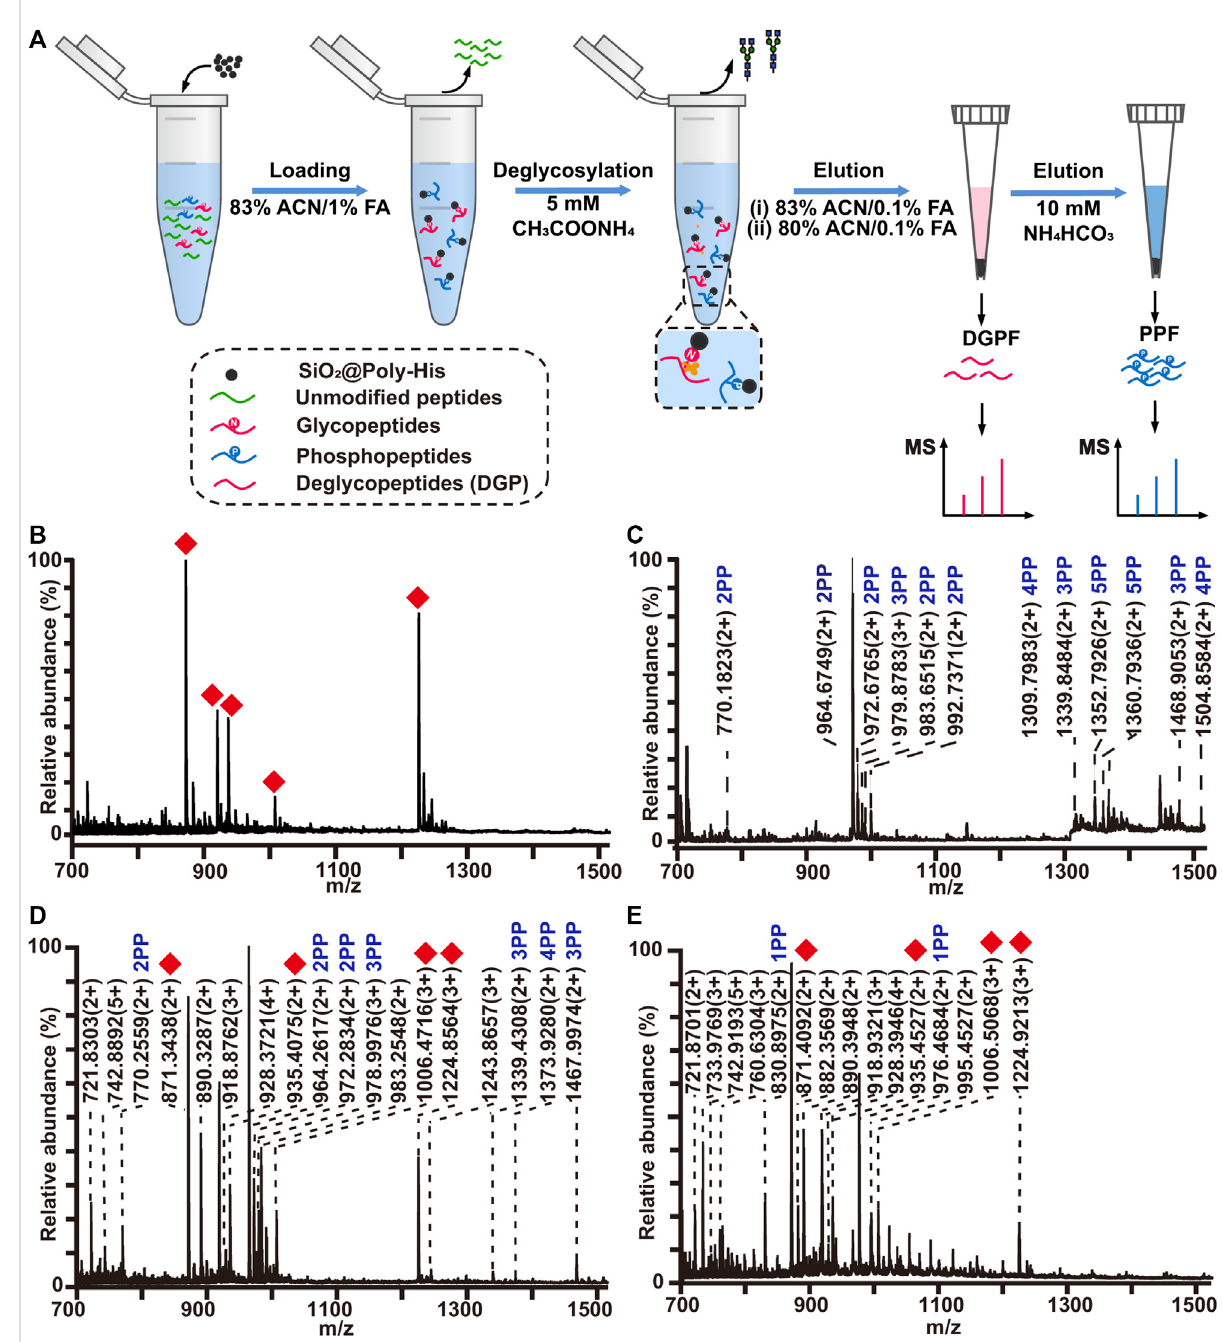
FIGURE 5 (A) Work fl ow the simultaneous enrichment with SiO 2 @Poly-His microspheres, which consists of the sequential elution of glycopeptides and phosphopeptides.Massspectrumofsequentialelution ofthedeglycosylatedpeptidesfraction (B) andthephosphopeptides fraction (C) enrichedby SiO 2 @Poly-His microspheres. Mass spectra of the co-elution of deglycosylated peptides and phosphopeptides that treated with SiO 2 @Poly-His microspheres (D) andcommercialTiO 2 materials (E) .Reddiamondrepresentsdeglycosylatedpeptide;XPPrepresentsphosphopeptide,among which X is the number of phosphate groups in a peptide; Only mass charge ratio (m/z) represents unmodi fi ed